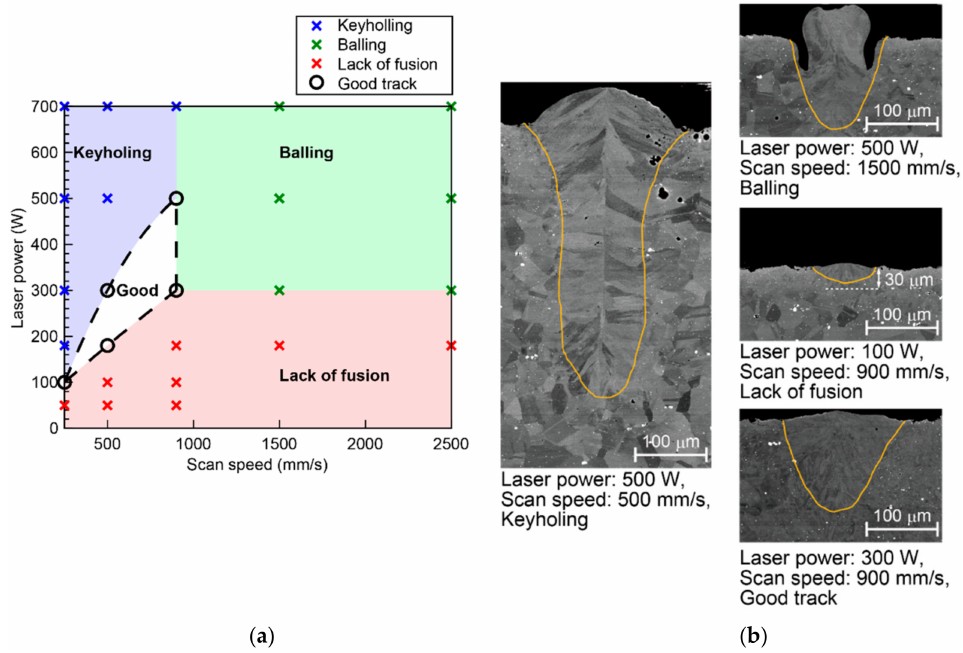
Figure 8. Defect-free process parameter map and cross-sectional image examples: ( a ) defect-free process parameter map; ( b ) cross-sectional image examples.